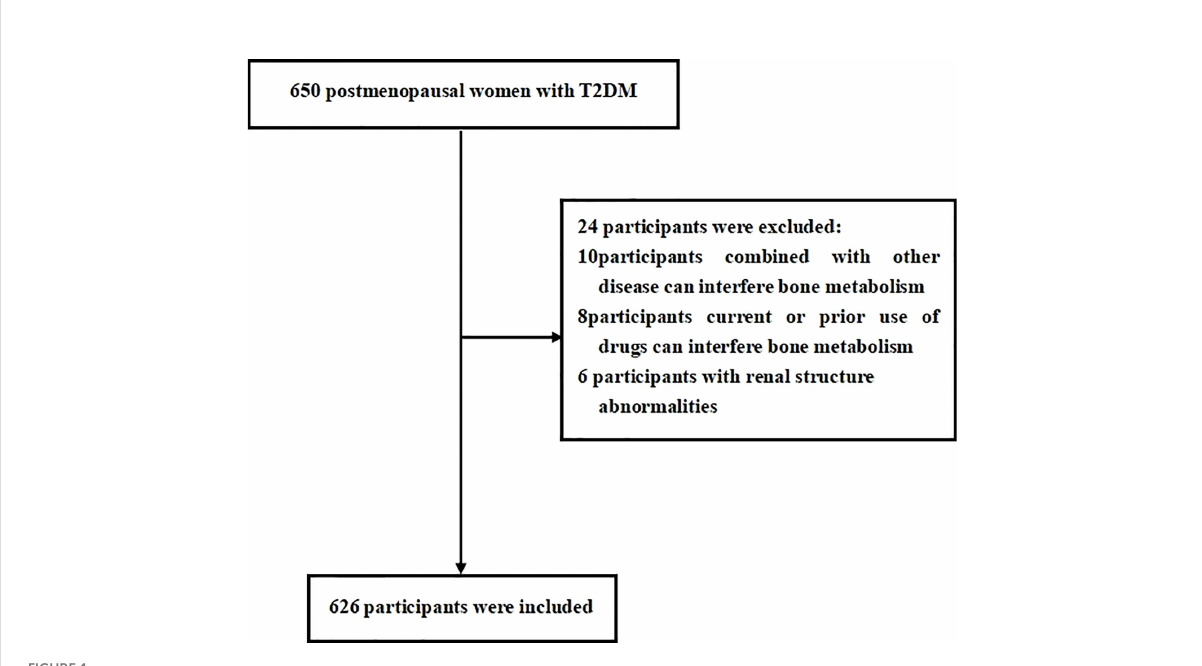
FIGURE 1 Flow diagram of the participants excluded and included in this